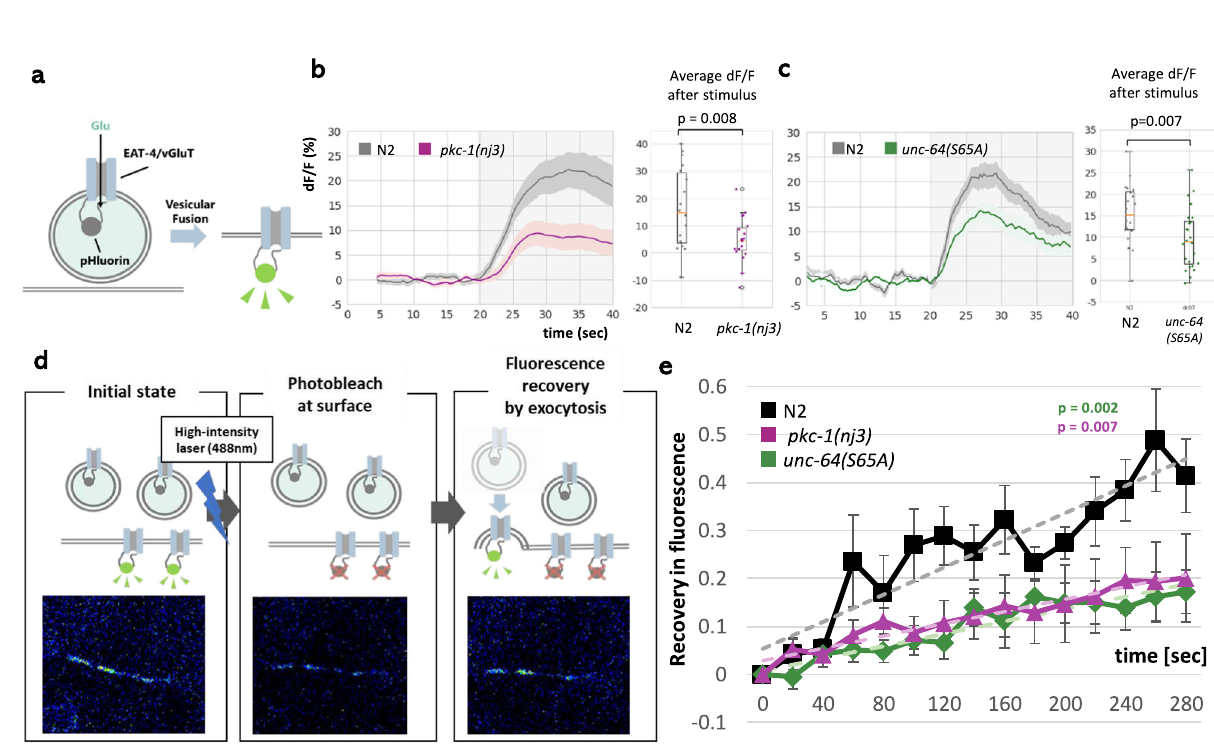
Fig. 4 Glutamate release from ASER is reduced in pkc-1(nj3) and unc-64(S65A) . a A schematic illustration of the fl uorescent reporter of glutamate release, eat-4: :pHluorin, used in B and C 22 . Release of glutamatergic synaptic vesicles causes increased fl uorescence. b Glutamate release is reduced in pkc- 1(nj3) mutants. n = 20 independent animals. c Glutamate release is reduced in unc-64(S65A) mutants. n = 20 independent animals. p values were calculated by the two sided Welch ’ s test (single comparison) or Tukey ’ s test (multiple comparisons). The gray vertical shade in b , c shows the decrease in NaCl concentration applied to the worm nose (50 – 25 mM). In b , c , left, the lines with the shade show the average and SEM, respectively, of changes in pHluorin fl uorescence, and in b , c , right, the boxes extends from 25th to 75th percentile, median is marked by the line, and whiskers indicate the minimum and the maximum values in 1.5× the inter-quartile range. d A schematic illustration of the FRAP of ASERp:: eat-4::pHluorin . EAT -4::pHluorin was photobleached using high-intensity 488 nm Argon laser until the fl uorescence decreased to ~50% of the original level. Once fl uorescent EAT-4::pHluorin at the surface membrane is photobleached, the fl uorescence is recovered according to the release of synaptic vesicle containing EAT-4::pHluorin. Since worms do not experience any change in NaCl concentration during image acquisition, this recovery in fl uorescence re fl ects the baseline release of glutamate. e The result of FRAP in wild-type animals, pkc-1(nj3) and unc-64(S65A) mutants ( n = 8 independent animals). Error bars indicate SEM. The time course of fractional recovery was linearly fi tted. p value were calculated by t values of interaction between time course and strains in generalized linear model with Bonferroni ’ s correction. Source data are provided as a Source Data fi le. parallel the direction of behavioral bias during navigation observed (Fig. 3d). In C. elegans , presynaptic transmission occurs in the in these mutants.